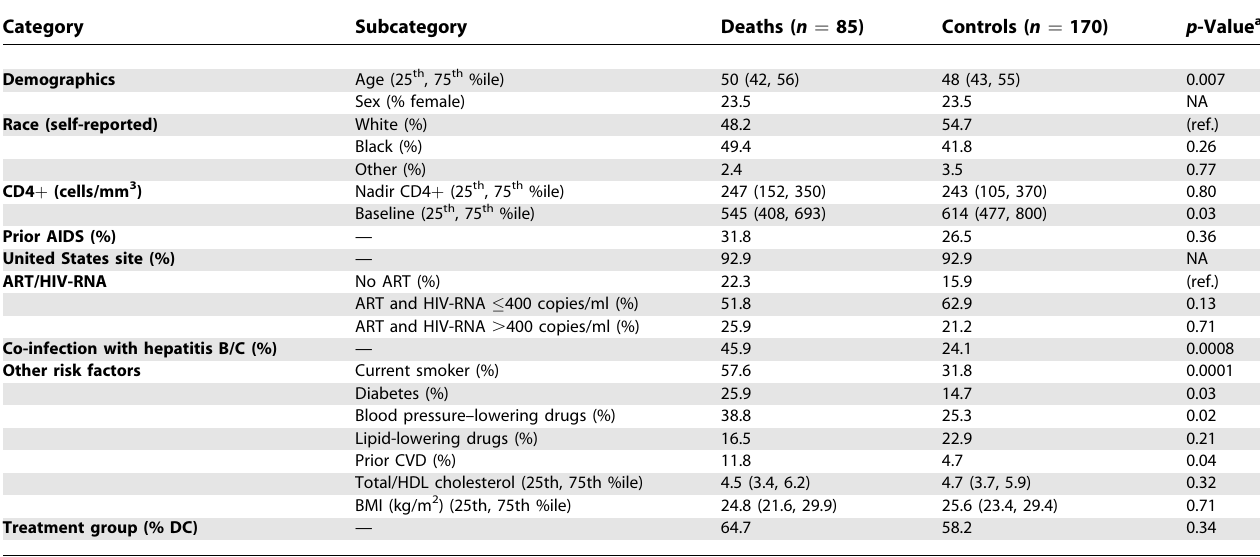
Table 1. Characteristics of Deaths and Matched Controls at Study Entry Category Subcategory Deaths ( n ¼ 85) Controls ( n ¼ 170) p -Value a Demographics